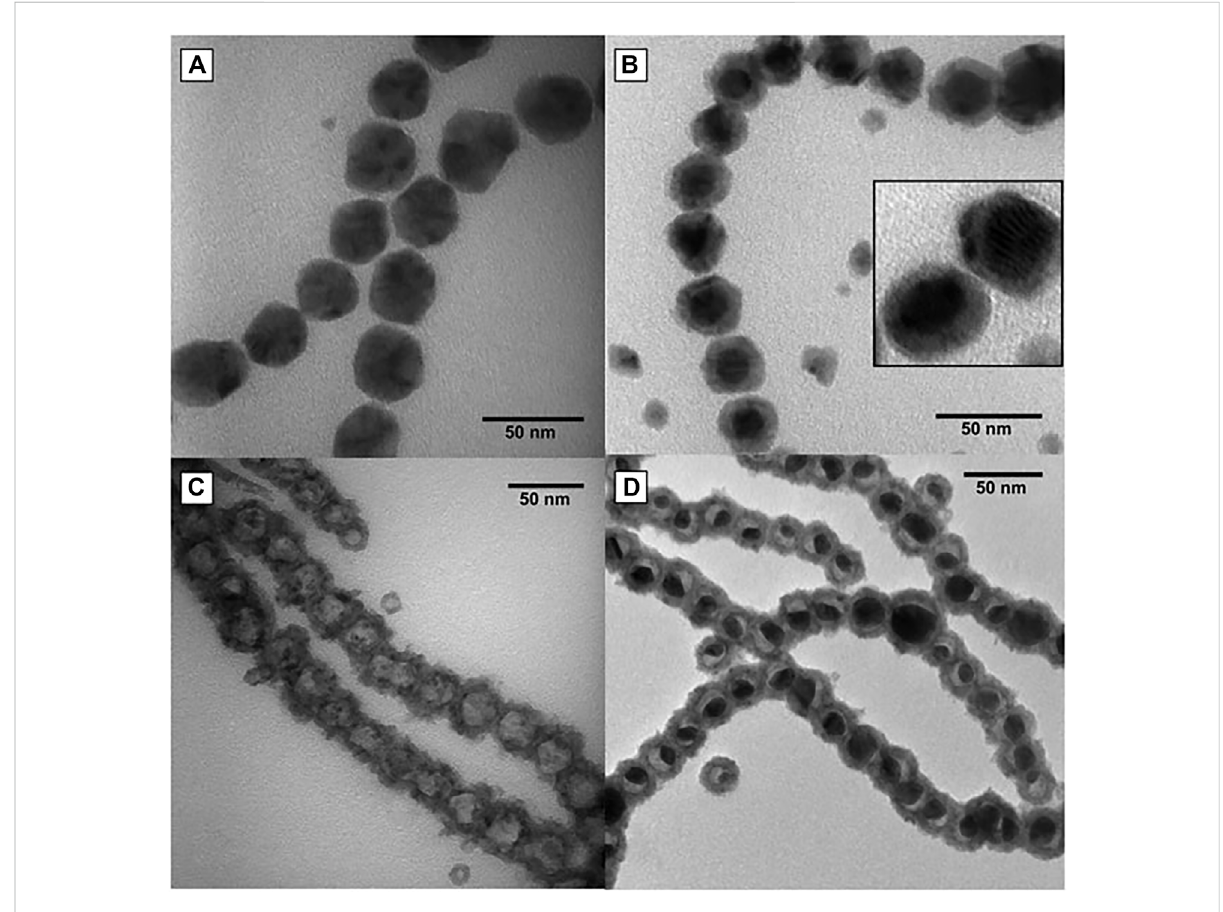
FIGURE 15 TEMimagesofmagneticnanoparticlechains. (A) Co, (B) Au/Co core-shell, (C) hollowCoOshells, and (D) hollowCoOshellscontainingsmaller Au nanoparticles. (Tracy and Crawford,